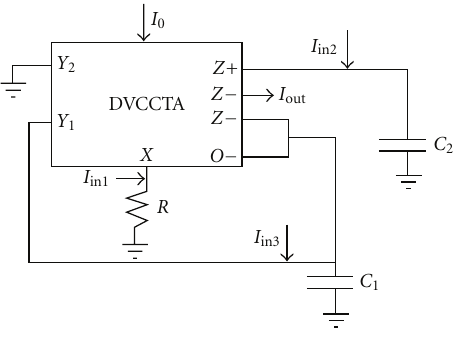
Figure 5: Current mode universal filter. Table 6: Component values for orthogonal adjustment of f 0 with Q 0 .